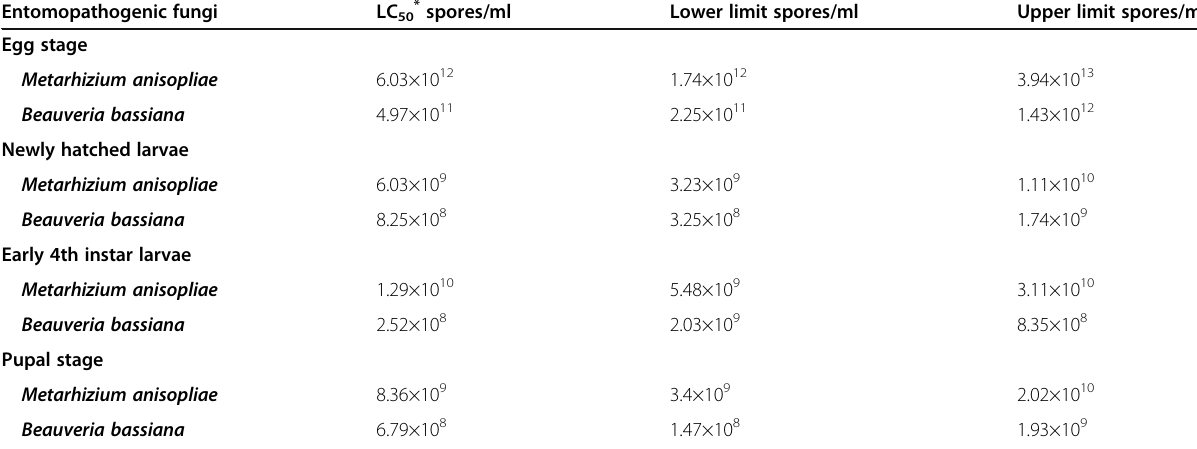
Table 5 LC 50 values of the fungal isolates on different stages of Pectinophora